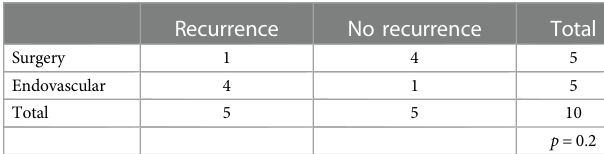
TABLE 3 Recurrence rate: Epidural AVF (number of treatment).